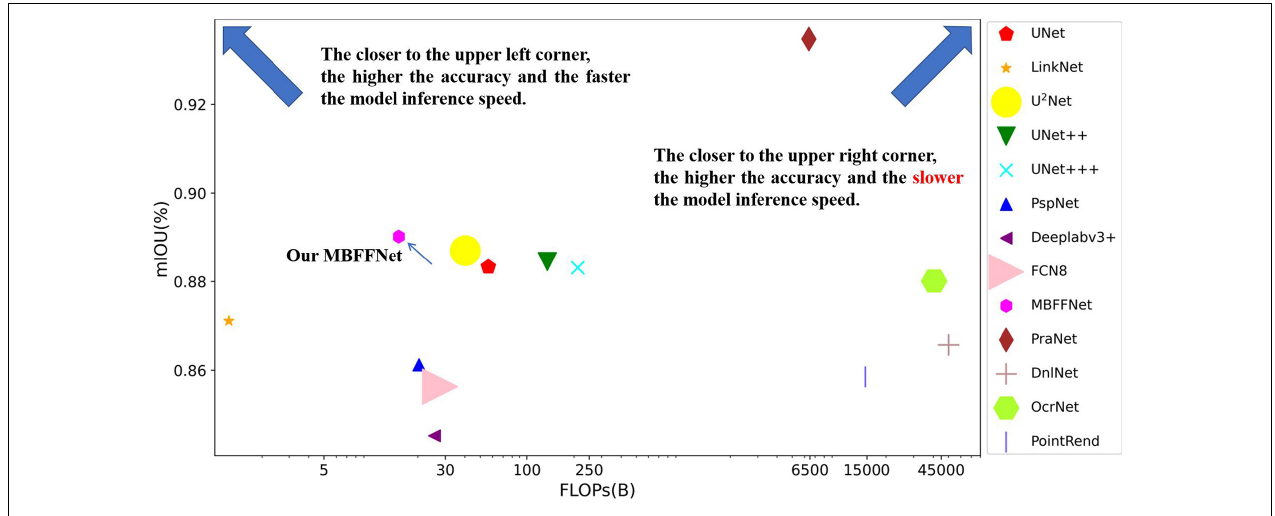
FIGURE 6 | Comparison between the accuracy of different models and flop count.